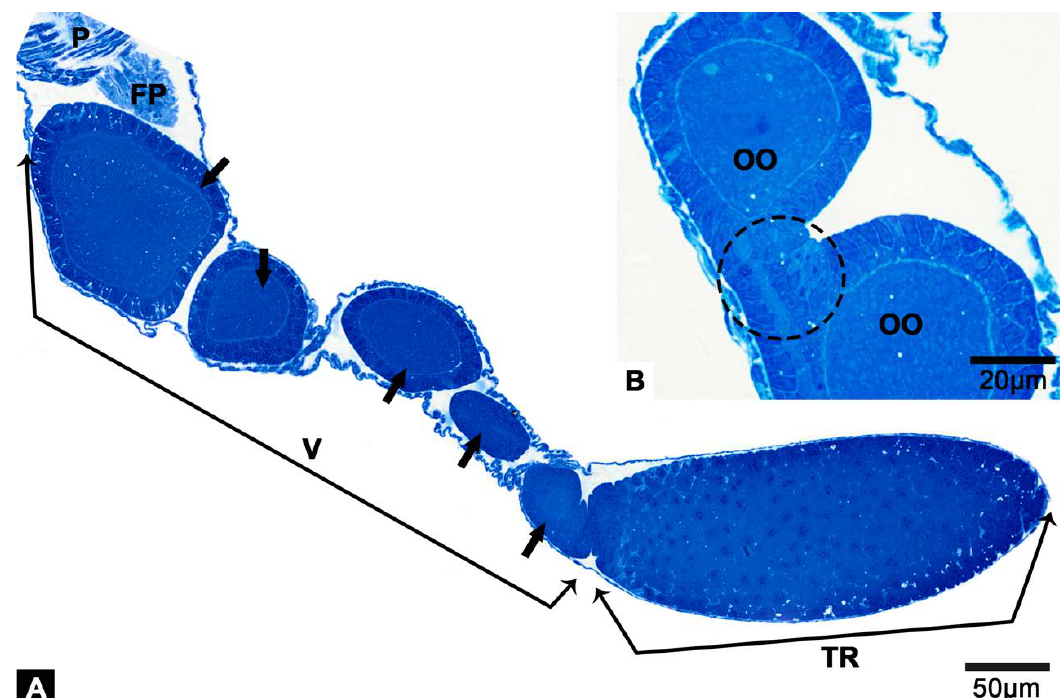
Figure 2. Logitudinal section of ovariole of T. klimeschi on sixteenth day post-eclosion. ( A ) Oocytes in successive stages of oogenesis (black arrows); ( B ) Adjacent oocytes are connected by follicular cells (dotted black circle). Vitellarium (V); tropharium (TR); oocyte (OO); follicular plug (FP); and pedicel (P).